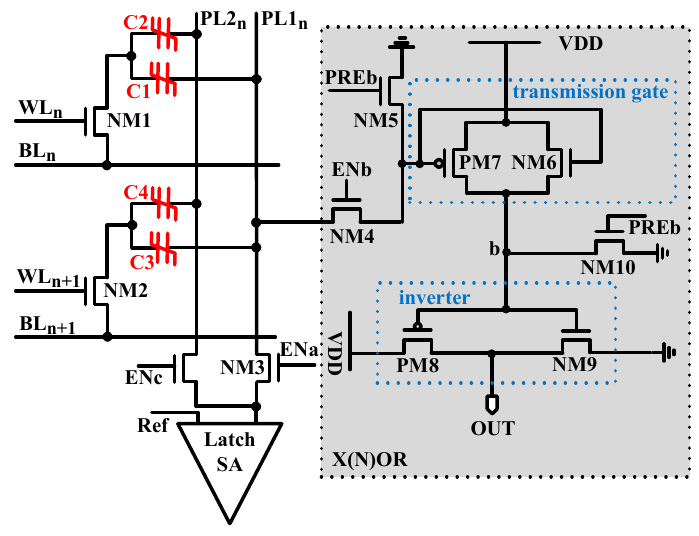
Figure 7. Schematic of the proposed mode switchable sense amplifier (SA). The X(N)OR circuit consists of a latch SA, an inverter, and a transmission gate. The working mode of the SA circuit is changed by using two transistors NM3 and NM4. The working mode of the proposed SA is switched to traditional SA when NM4 is turned off, and NM3 is turned on. Conversely, the work mode of the proposed SA is switched to X(N)OR operation when NM3 is turned off, and NM4 is turned on. As shown in Figure 8, the X(N)OR operation is divided into three phases. In the precharging phase, the residual charge on PL1 and node b is released by the two precharge transistors NM5 and NM10. In the charge-sharing phase, the charges in C1 and C3 are dashed out. Meanwhile, the amount of charges of C2 and C4 remains constant. Then, PL1 is charged using the function of charge-sharing of the two FeCAPs, C1 and C3. In the X(N)OR phase, the on–off states of transistors PM7 and NM6 are determined by the voltage of PL1(VPL1) to realize X(N)OR.